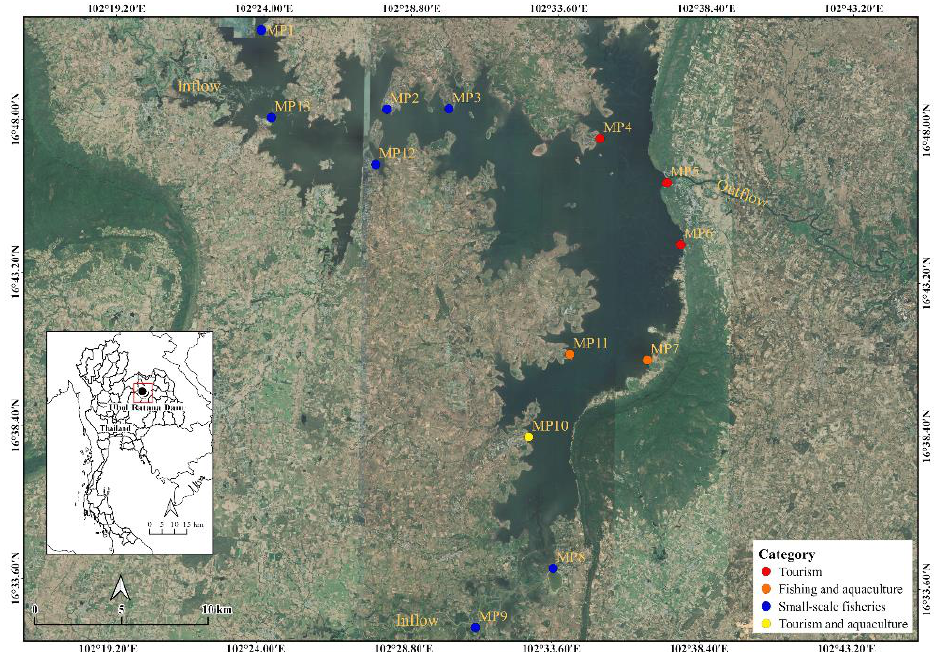
Figure 1. Surface water and sediment sampling sites in the Ubolratana Reservoir, Thailand.